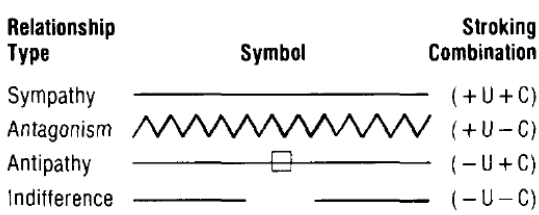
Figure 1: Relationship Qualities (Summerton, 1979, p. 116)